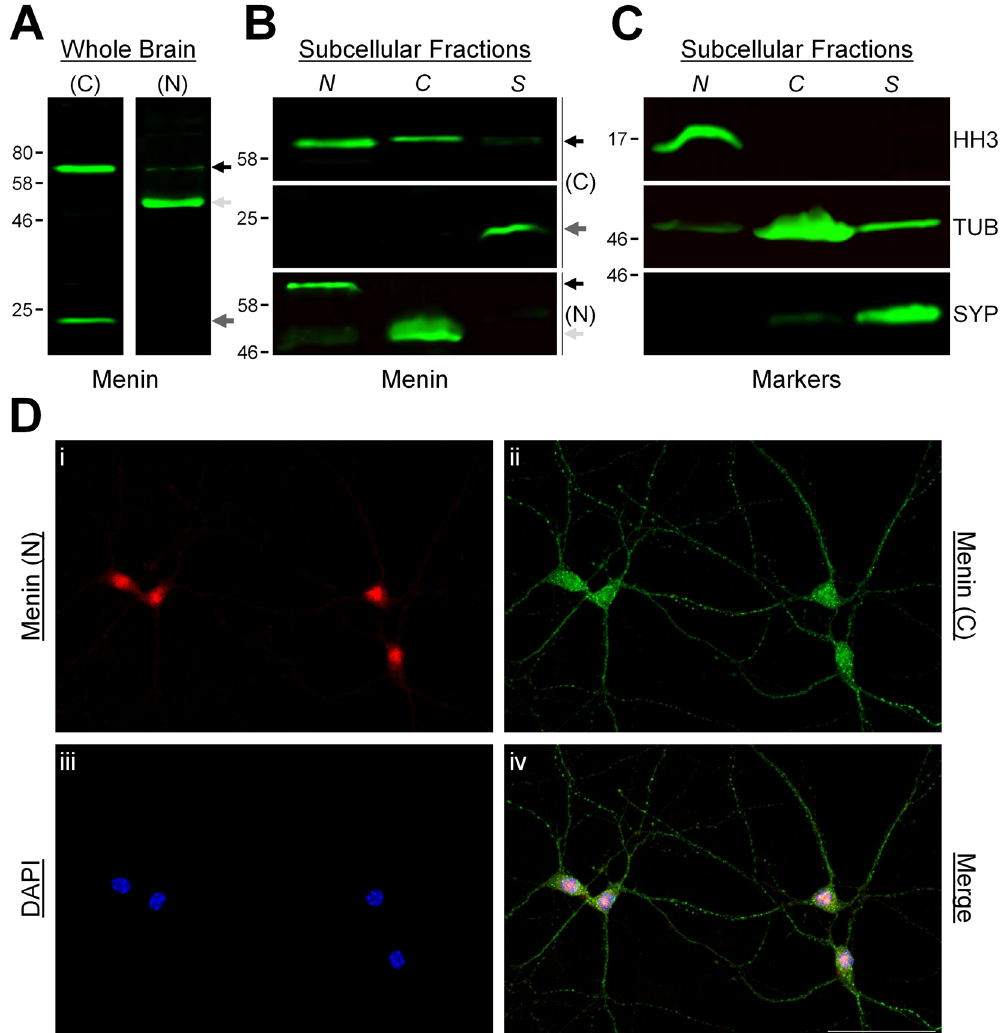
Figure 1. Menin fragments are differentially localized in neurons. ( A ) WB of mouse whole brain protein samples with menin C-terminal ((C); left panel) and N-terminal ((N); right panel) epitope antibodies (n = 3 each, representative blots), depicting full length menin (black arrow), as well as N-terminal (light grey arrow) and C-terminal (dark grey arrow) menin proteolytic fragments. ( B ) WB of subcellular fractions from mouse brain protein samples with menin C-terminal ((C); top and middle panels) and N-terminal ((N); bottom panel) epitope antibodies (n = 6, representative blots). N denotes nuclear fraction, C denotes cytoplasmic fraction, S denotes synaptic fraction. Menin localizes to the nucleus, the C-menin fragment localizes to synaptic membranes, and the N-menin fragment localizes to the cytoplasm. ( C ) As in ( B ), the markers histone H3 (HH3; nuclear marker, top panel), β -tubulin (TUB; cytoplasmic marker, middle panel), and synaptophysin (SYP; synaptic marker, bottom panel), are shown to verify the subcellular fractions. ( D ) ICC localization of menin in hippocampal cultures at DIV 7 (n = 13 images, 4 independent samples, representative image), with N-terminal (i) and C-terminal (ii) epitope antibodies, and the nuclear stain DAPI (iii), (iv) shows merged channels. α -N- terminal menin signals are restricted to the nuclear and perinuclear region, α -C-terminal menin signals also exhibit punctate localization along neurites. Scale bar, 50 μ m. See also Figs S1 and